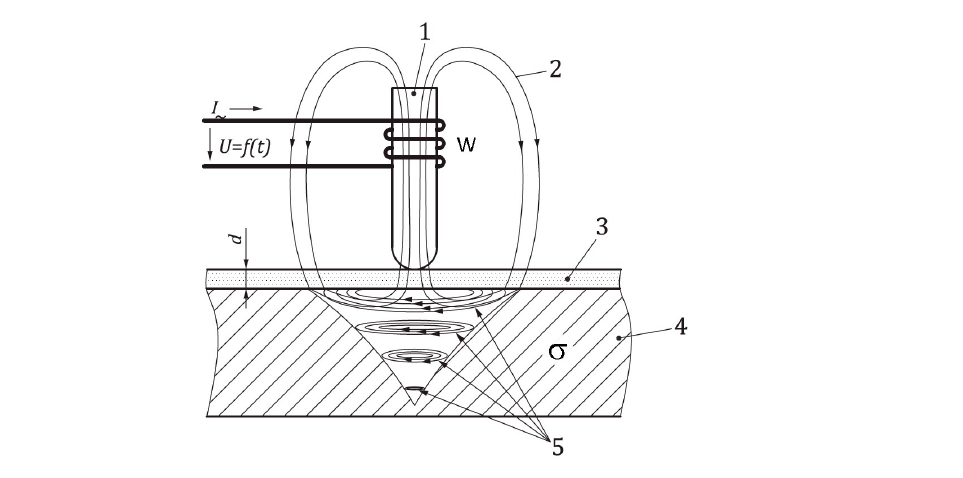
Figure 1. Amplitude-sensitive eddy-current method of measurement of the thickness of coating. 1—probe core with coil W, 2—high frequency magnetic field, 3—non-conductive coating, 4—non-magnetic electrically conductive base metals, 5—induced eddy current, I —exciting current, U —signal of eddy-current converter.